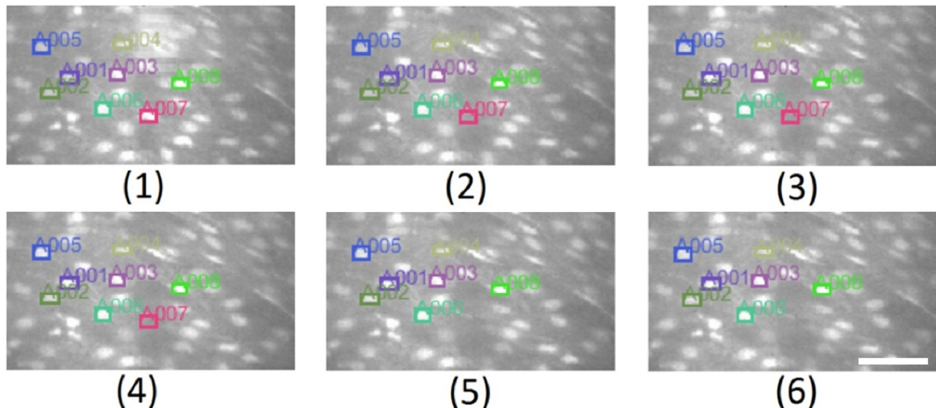
Figure 9. Tracking results through six consecutive frames. Eight cells were selected by the user, only ONLINE cells are labeled, ROI surrounded and tracked. OFFLINE cells are not tracked as shown with cell A007; the cell is visible at frame ( 1 ), then it vanishes as of frame ( 2 ) and its reliability counter increases by one between frames ( 2 – 4 ). At frame ( 4 ) its reliability counter is equal to RL = 3, then it is tagged as OFFLINE and is not tracked as of frame ( 5 ). Frame ( 6 ) shows the tracking of remaining ONLINE cells. Bar length is 40 μm.